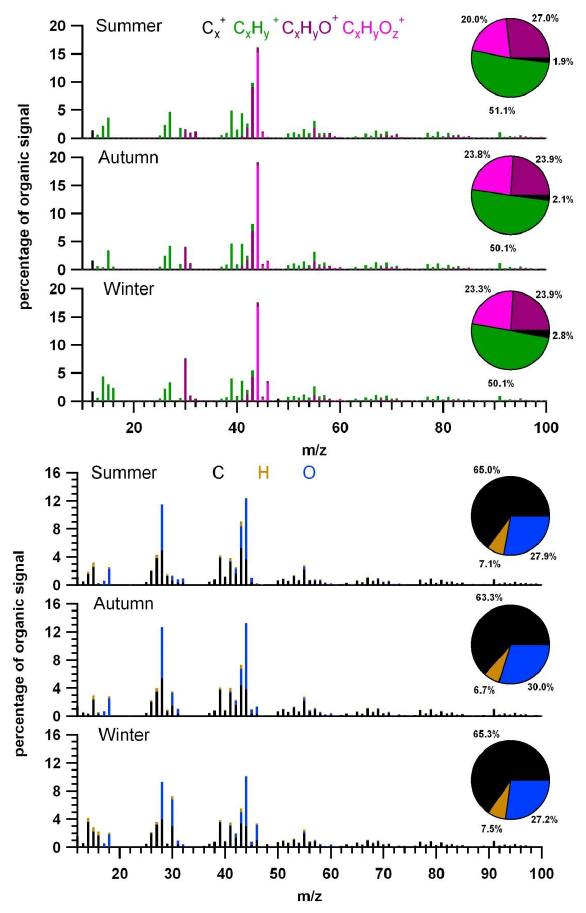
Figure 2. Comparison of the average organic mass spectra for each season, color code stand 2 Fig. 2. Comparison of the average organic mass spectra for each for the main organic categories (top) and the main elements (C, H, and O) (bottom). The pie 3 season, color code stand for the main organic categories (top) and charts represent the average mass fraction of the different ion categories and elemental 4 the main elements (C, H, and O) (bottom). The pie charts repre- composition of each mass spectrum. 5 sent the average mass fraction of the different ion categories and elemental composition of each mass